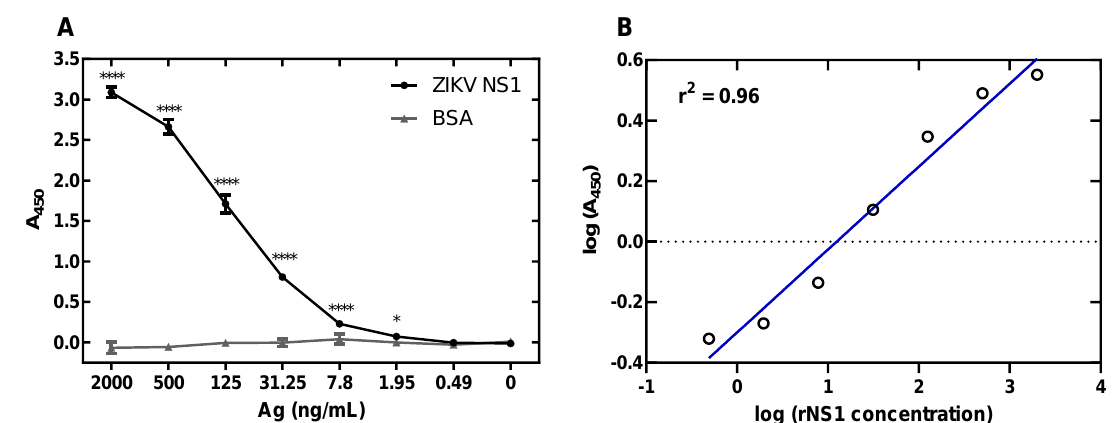
Figure 6. ZIKV NS1 antigen-capture ELISA limit of detection and dynamic range. ( A ): ZIKV rNS1 shows binding significantly higher than BSA down to 7.8 ng/mL. The limit of detection of the assay is between 7.8 and 1.95 ng/mL NS1. ( B ): Linear regression of NS1 detection via ELISA demonstrates assay can quantify protein across a range of values. Comparisons were made using two-way ANOVA with a Holm–Sidak multiple comparisons test. Asterisks represent significant comparisons (**** p < 0.0001; * p < 0.05). Error bars represent the standard error of the mean.